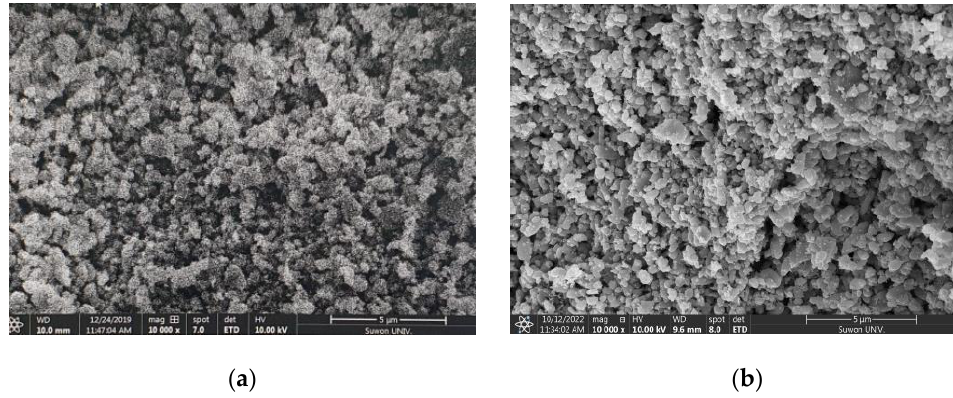
Figure 3. SEM images of ( a ) Fresh and ( b ) Spent 3 wt.% Ni/Ce-Zr-Mg/Al 2 O 3 catalysts.